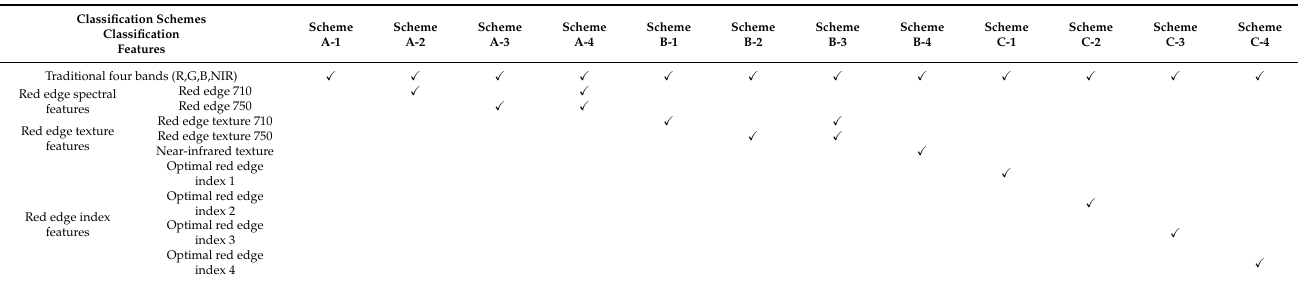
Table 4. Different red edge feature classification